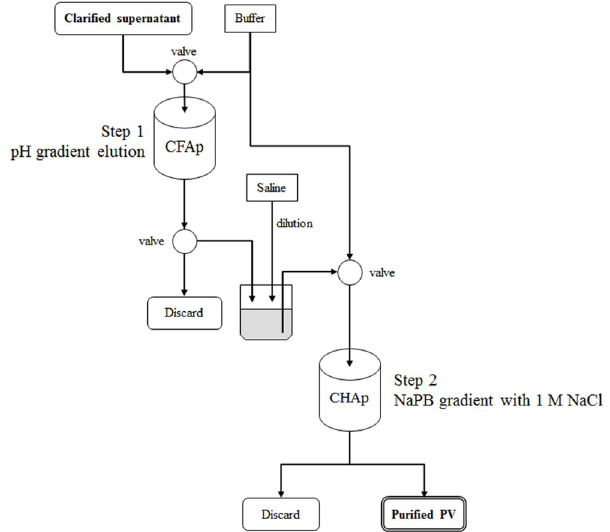
Fig 5. Tandem column system. CFAp, ceramic fluoroapatite; CHAp, ceramic hydroxyapatite; NaPB, sodium phosphate buffer; PV, poliovirus.